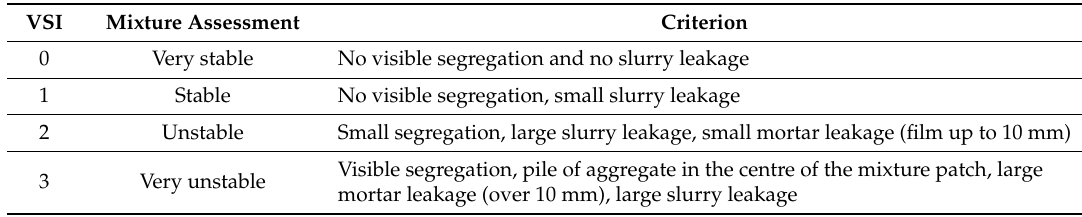
Table 7. Visual Stability Index (VSI) for the assessment of self-compacting mixtures